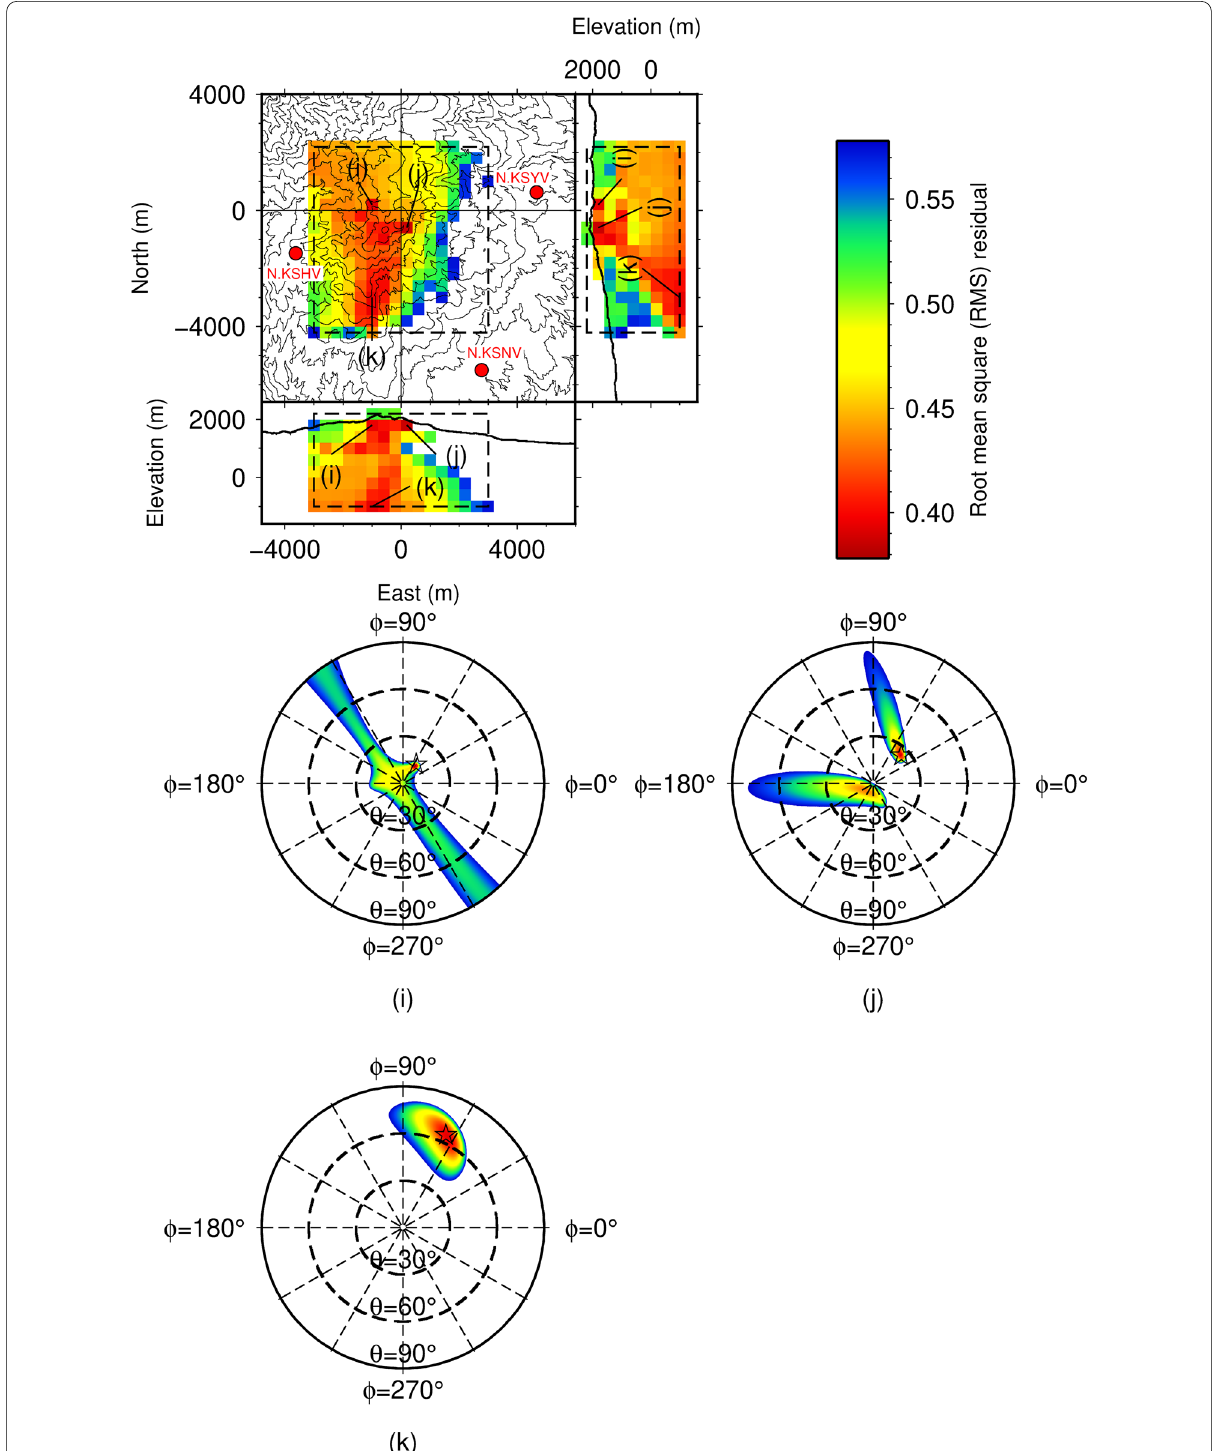
Fig. 8 Spatial distribution and crack orientation dependence of the RMS residuals between the observed and synthetic waveforms obtained by waveform inversion using the three-component broadband seismograms and the two-component tiltmeter records at the three stations except for the NS component seismogram at N.KSHV (14 components). The locations of candidates ( i ), ( j ), and ( k ) are indicated by straight lines on the plane map. See Fig. 5 for details concerning the plotting